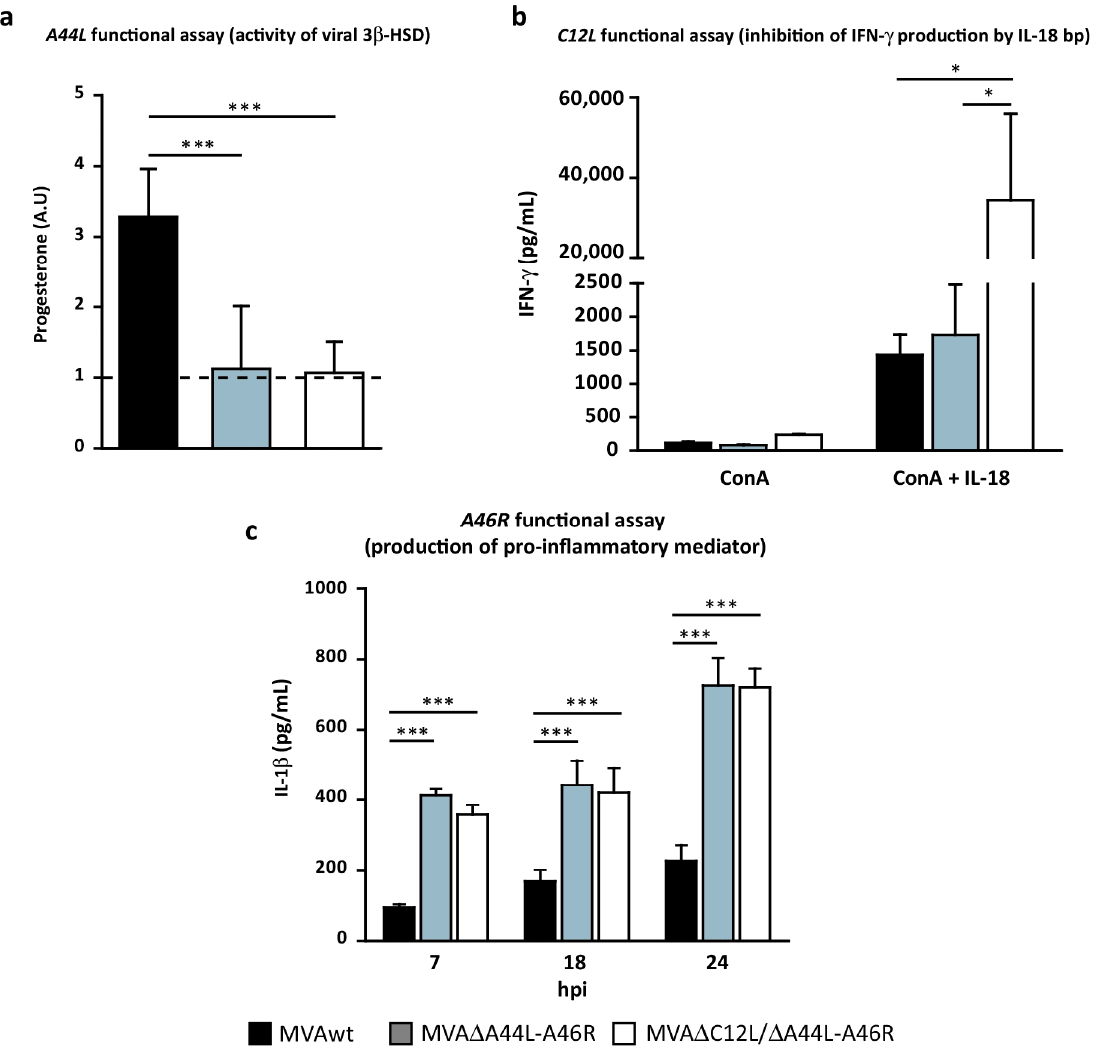
Figure 2. Functional assays of selected genes A44L , C12L , and A46R . ( a ) In vitro progesterone production after infection of BSC-40 with the indicated virus. Progesterone was normalized to an internal control (to check extraction efficiency of steroids) and then related to mock levels (dotted-line). Mann-Whitney test; ( b ) Splenocytes from naïve mice treated with ConA (0.2 ug/mL) alone or combined with rIL-18 (10 ug/mL) were incubated with supernatants (virus-free) from BHKs infected with the indicated MVAs. IFN- γ was quantified in splenocyte-culture supernatants by ELISA after 24 h; ( c ) In vitro quantification by ELISA of pro-inflammatory mediator in supernatants of THP-1 after infection with distinct MVAs. Two-way ANOVA and Bonferroni’s post-test. Statistically significant differences: * p < 0.05, *** p < 0.001.